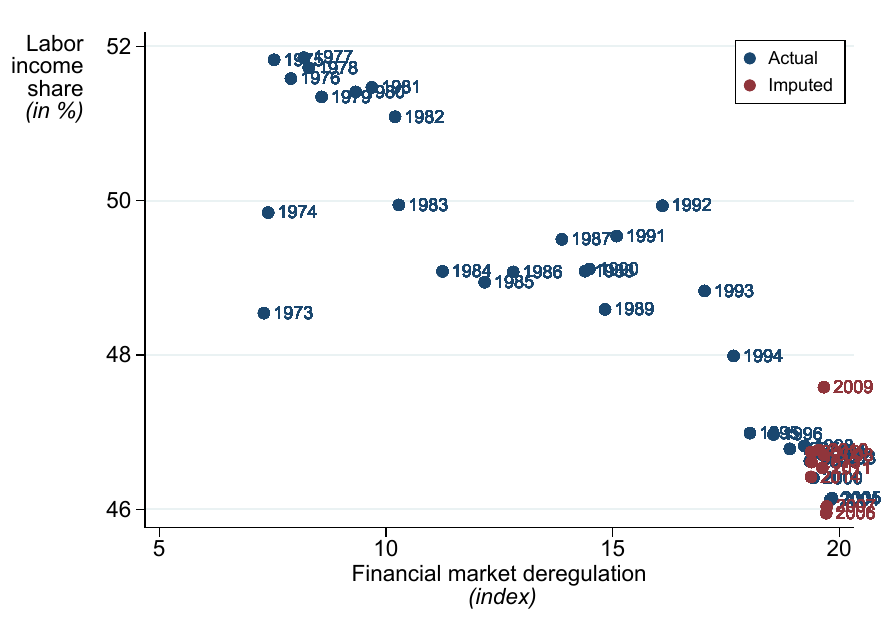
Figure 1. Labor income share and financial market reforms in the OECD (1973–2014). Note: The chart displays the average (employment weighted) labor income share in a sample of 20 OECD countries against the IMF financial market reform index between 1973 and 2014. The labor income share measures the some of wages as a share of nominal GDP (in percent). Values of the financial market reform index for years after 2005 have been imputed, using the method described in Section 5. Source: OECD Economic Outlook database, Abiad et al.